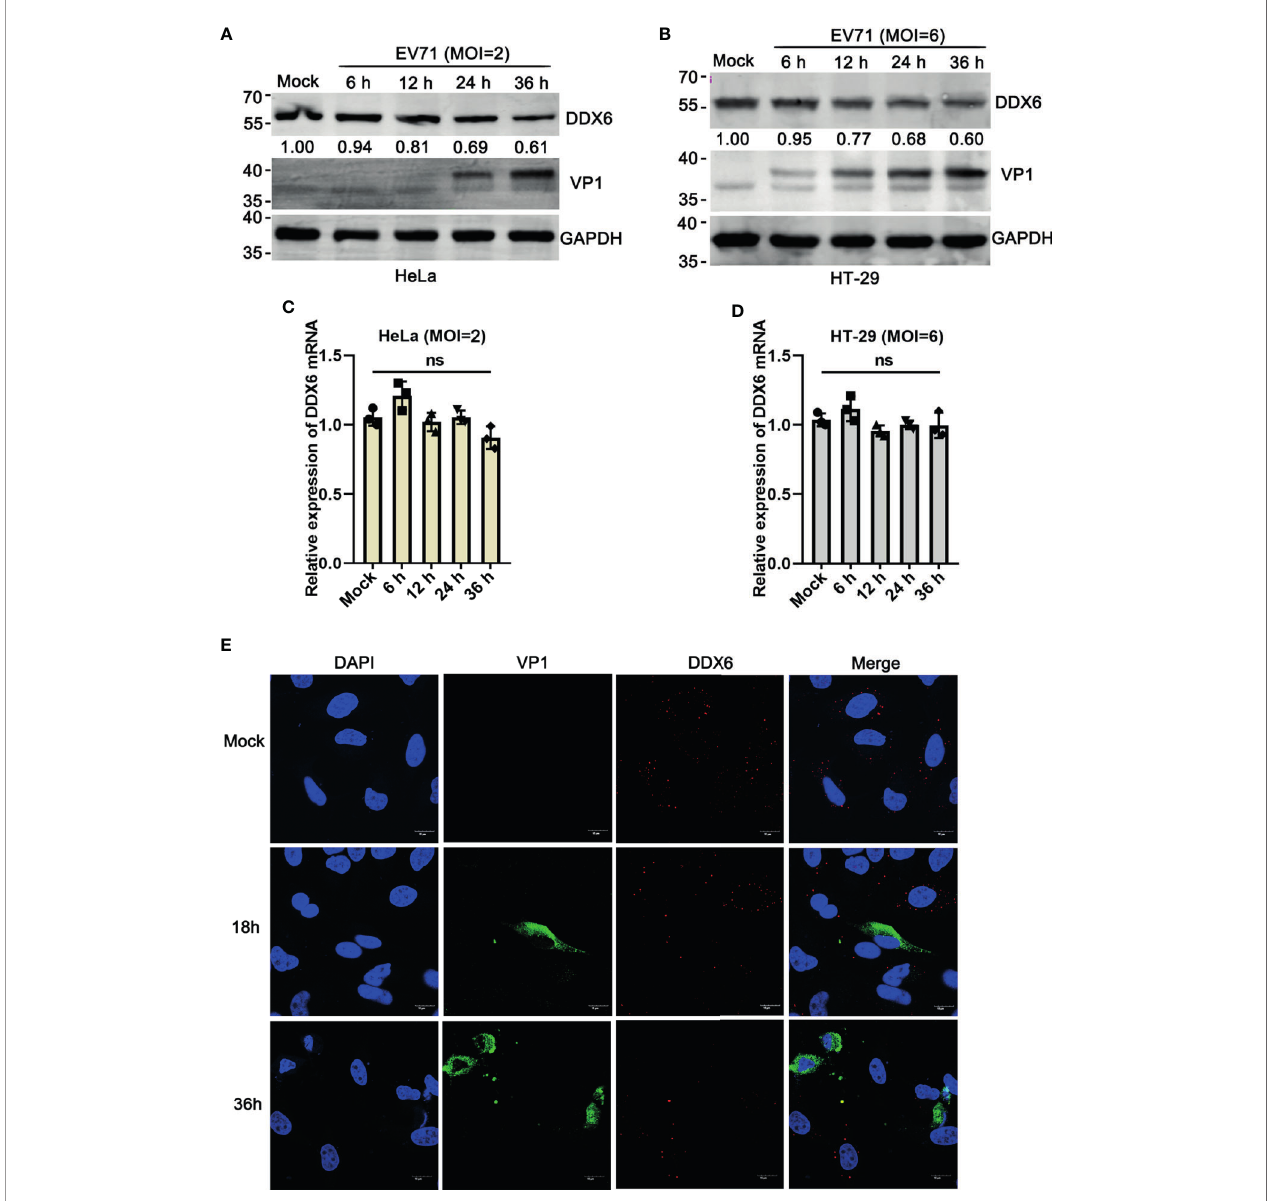
FIGURE 1 | EV71 reduced P-body component DDX6 but did not affect de novo expression. (A, B) EV71 infection reduces endogenous DDX6. HeLa and HT-29 cells were infected with EV71 under different MOIs for the indicated times, respectively. Cell lysates were determined by Western blot using antibodies against DDX6, VP1, and GAPDH. The value of DDX6 in uninfected cells (Lane1) is set as 1.00. The representative data are shown. (C, D) The mRNA of DDX6 showed no change after EV71 infection. The total cell RNA was extracted, and DDX6 mRNA was analyzed by real-time PCR assay, GAPDH as control. All these experiments were performed three times, and representative results were shown. ns indicate no signi fi cant difference. (E) HeLa cells grown on 12-well slides were infected with EV71 (MOI=2) or control treatment. After the corresponding time treatment, the cells were fi xed and stained with antibodies against DDX6 (red), VP1 (green), and DAPI (blue); the images were acquired using a confocal microscope, and a representative of three independent experiments was